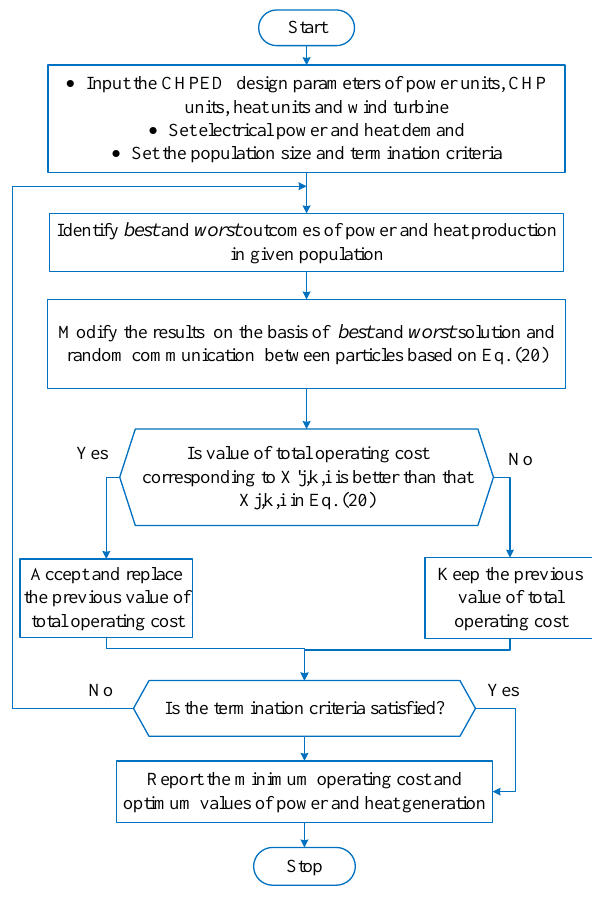
Figure 3. Flow chart of Rao-3 algorithm.